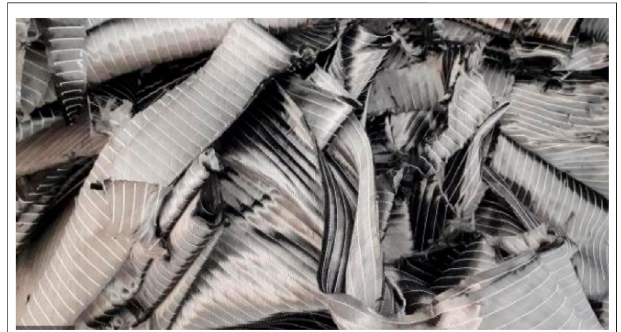
FIGURE 2 | Cut pieces of waste carbon fi